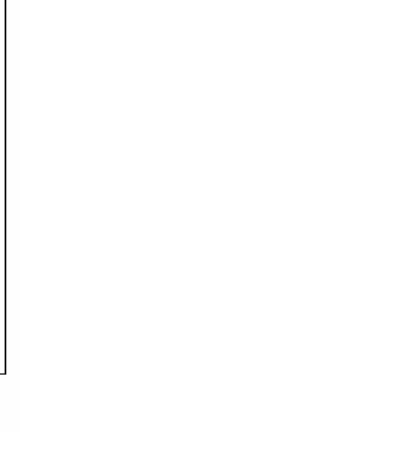
Figure 7. Simple and equity payback period of all